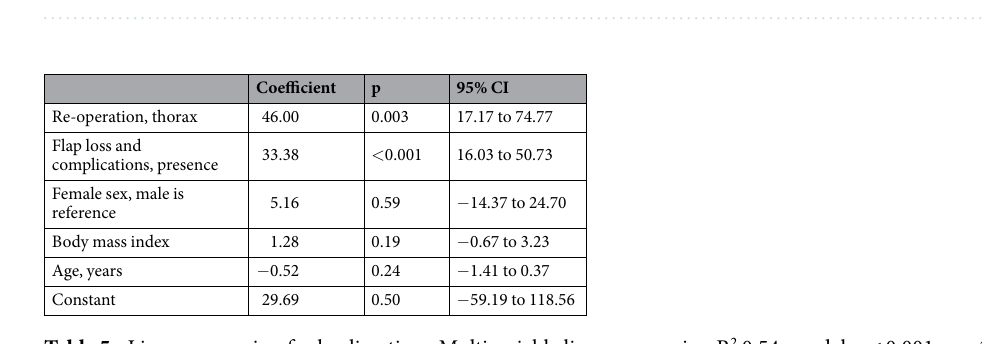
Table 5. Linear regression for healing time. Multivariable linear regression R 2 0.54, model p < 0.001, n =